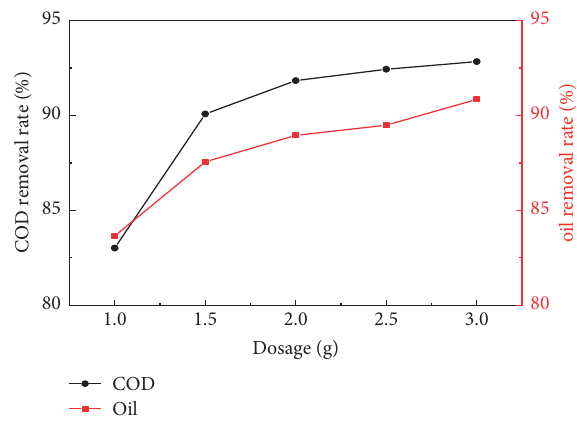
Figure 3: Influence of dosage on COD and oil removal rate in oilfield wastewater.